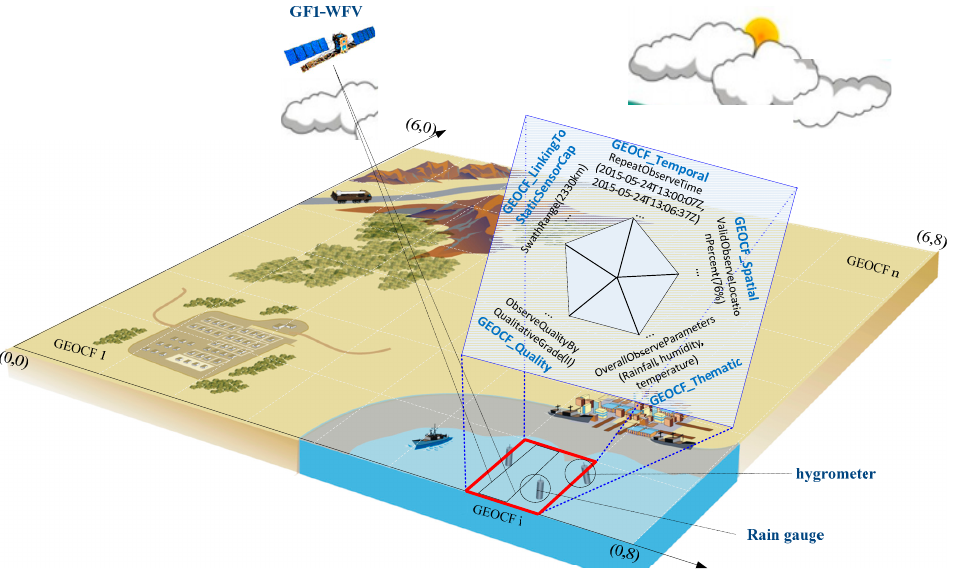
Figure 3. GEOCF virtual scene for environmental sensor discovery and collaboration. In the given grid cell-based geospatial observation unit (marked in red), the discovered sensors include GF1-WFV, a hygrometer, and a rain gauge; the solar elevation angle is nearly vertical, and the cloud coverage is high.